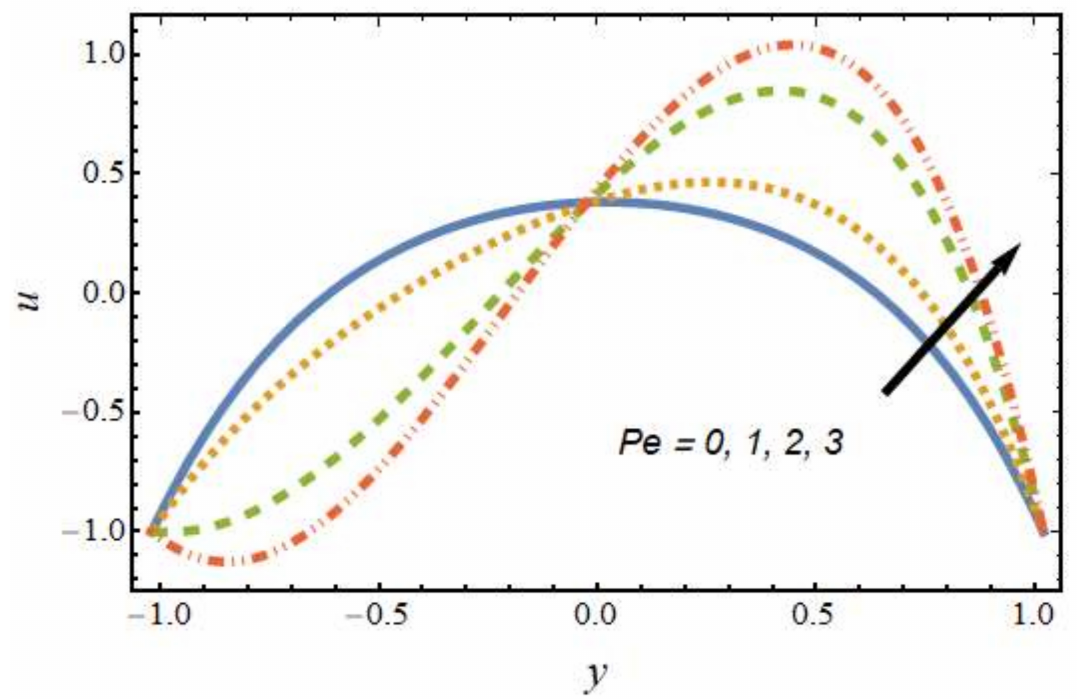
Figure 2. Velocity profile for various values of the Peclet number.